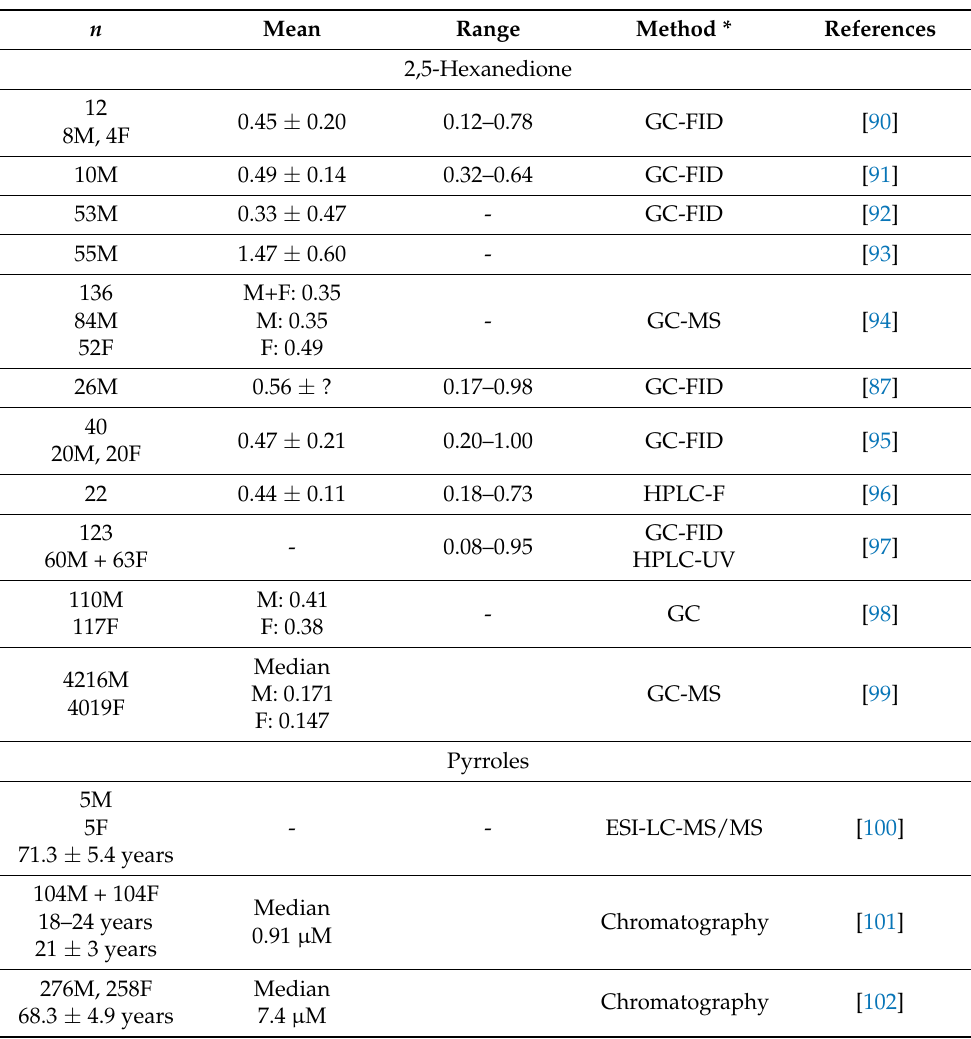
Table 1. Total * urinary 2,5-hexanedione (mg/L) and 2,5-dimethylpyrroles in populations with no known exposure to n -hexane or 2-hexanone. n